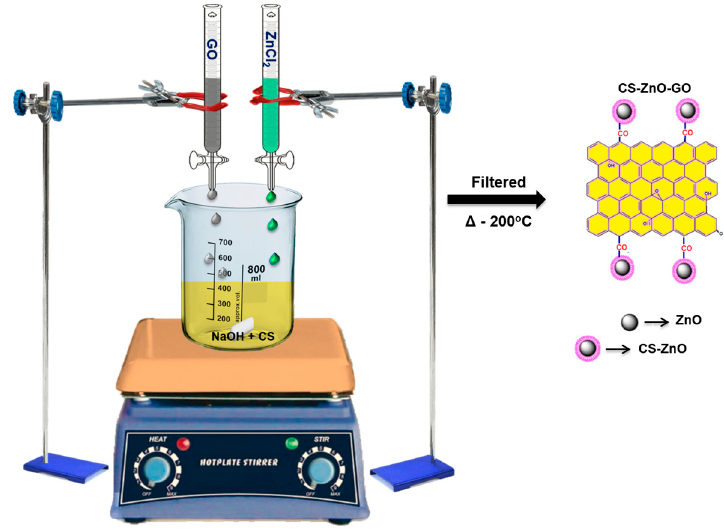
Figure 1. Schematic diagram for chitosan–ZnO–graphene oxide (CS–ZnO–GO) hybrid composite preparation.